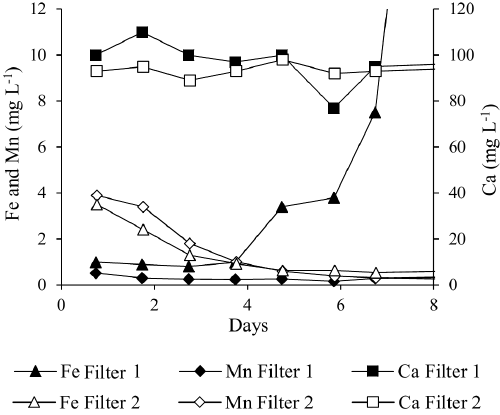
Figure 2. Time series of metal concentrations in backwash water composites.